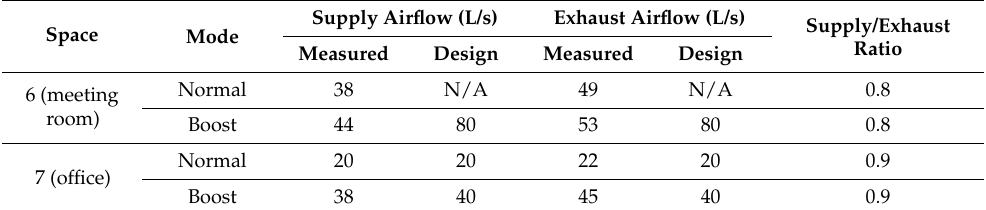
Table 9. Measured and designed airflows for Type 3 spaces (air–water system with normal and boost modes).